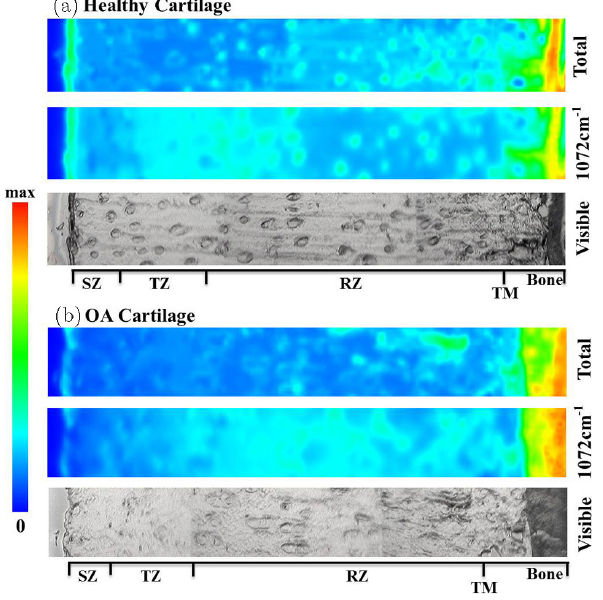
Fig. 3. (a) Cumulative percent variance contributions of principal components in the PLS-DA and PCA model. (b) PCA scores plot (PC1versus PC2) for the analysis of the FTIR spectra originated from ( (cid:4) ) healthy cartilage and ( N ) OA cartilage.